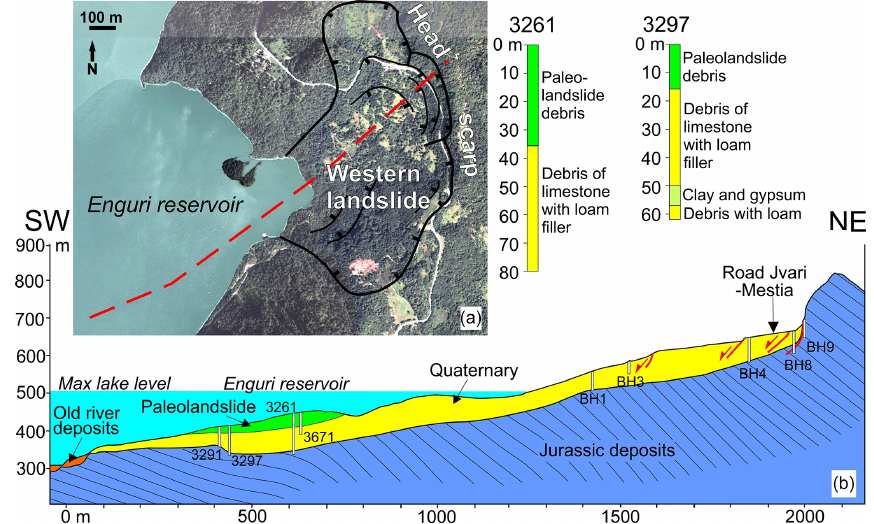
Figure 8. (a) Trace (red line) and (b) geological section across the slope facing the Enguri reservoir. White columns represent locations and depth of logs used to construct the cross section. Data of the submerged part, derived from geological surveys conducted in the Soviet era before dam construction, are shown. Two examples of detailed logs (3261 and 3297) are